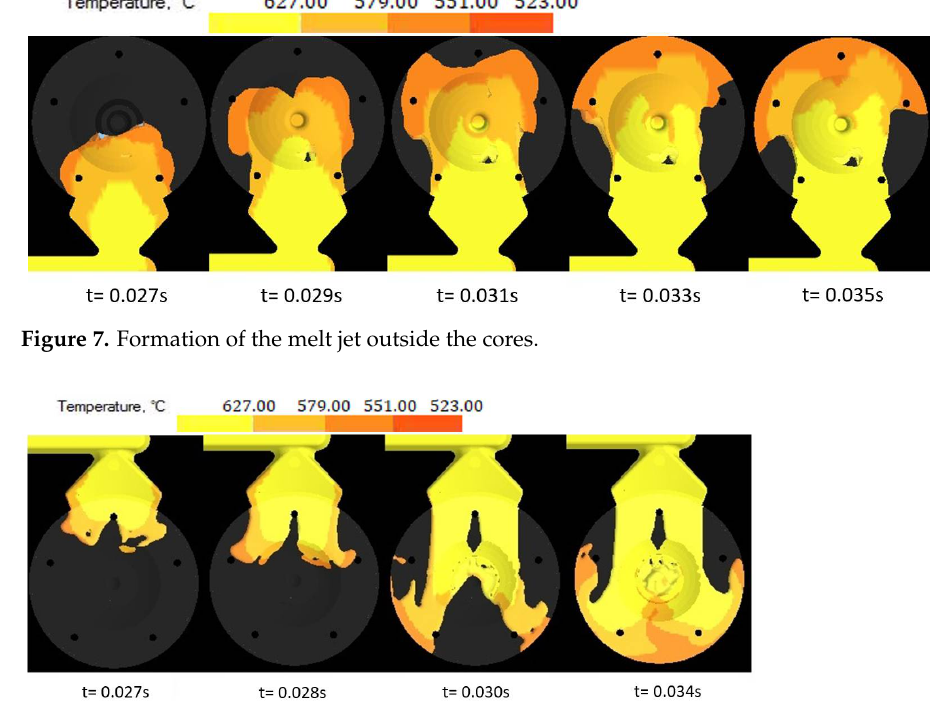
Figure 8. Formation of the melt jet when hitting against the core.